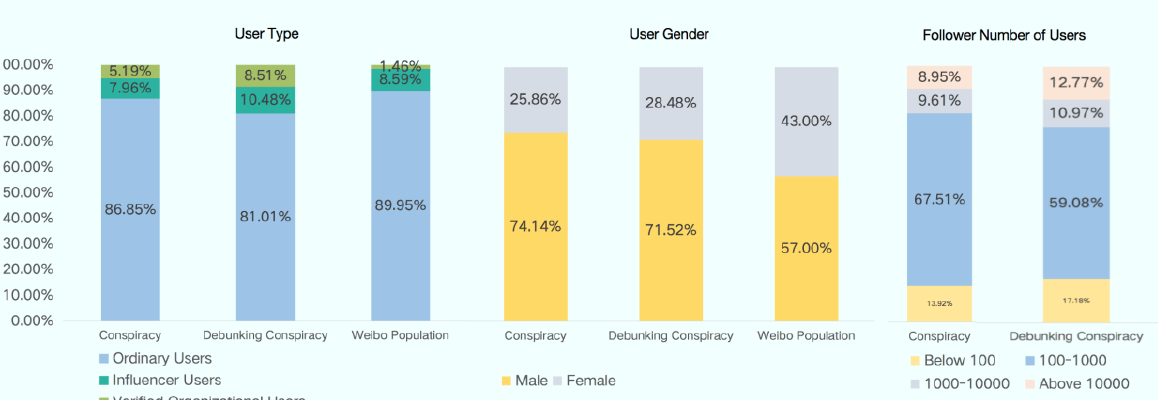
Figure 3. Conspiracy propagation and debunking behaviors by user type . Note: Data on “the number of followers” for the general Weibo population is not available